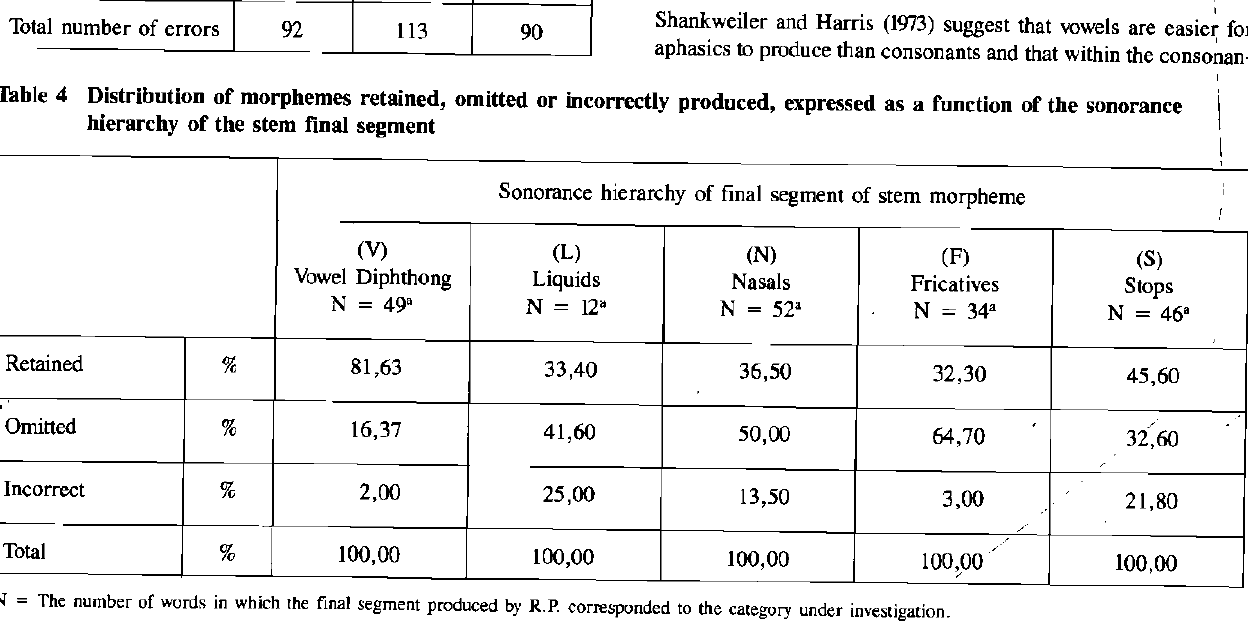
Table 4 Distribution of morphemes retained, omitted or incorrectly produced, expressed as a function of the sonorance hierarchy of the stem final